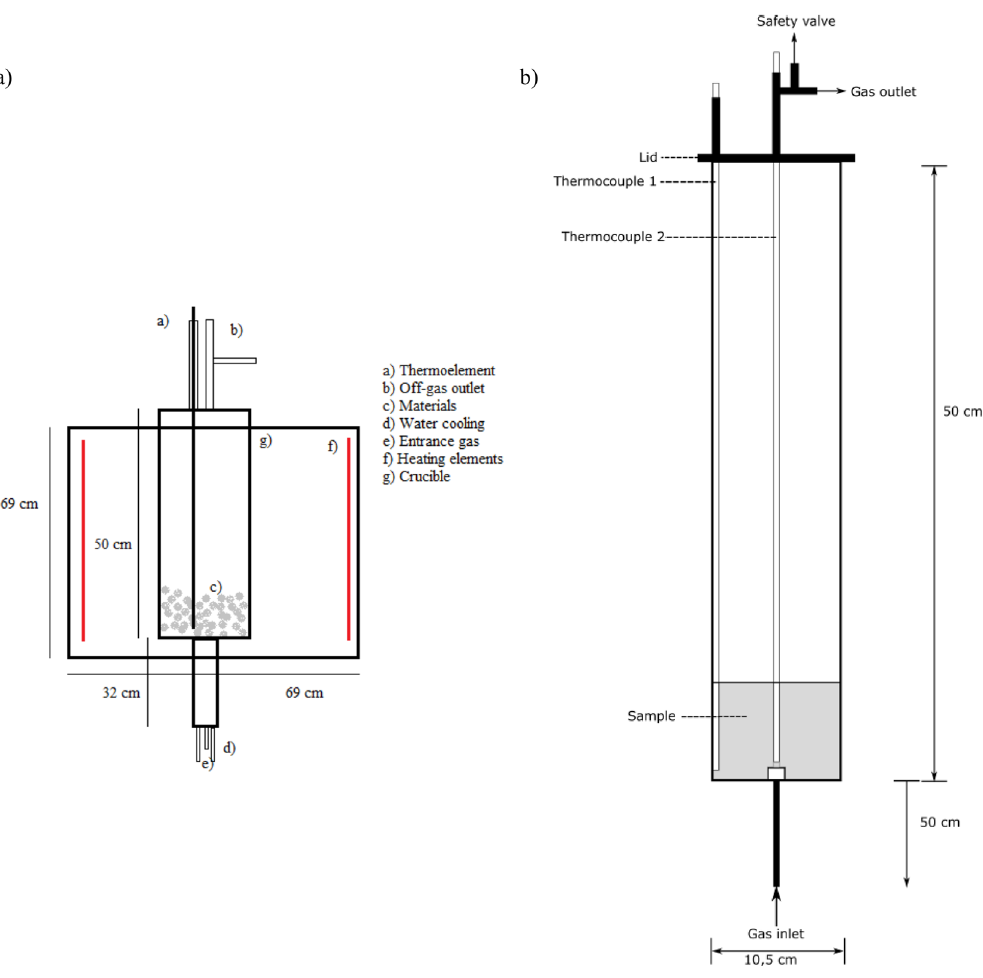
Figure 2. Sketch of the experimental setup. ( a ) Sketch of the whole furnace chamber 19 , while ( b ) shows the crucible in more